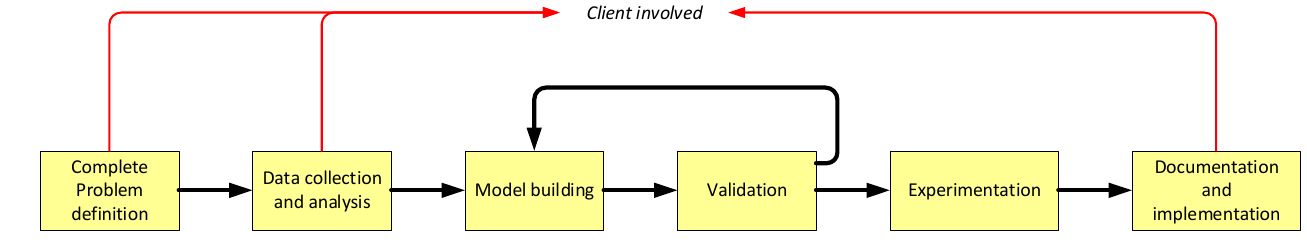
Figure 1. Conventional simulation modelling process, redrawn from Robinson [6].